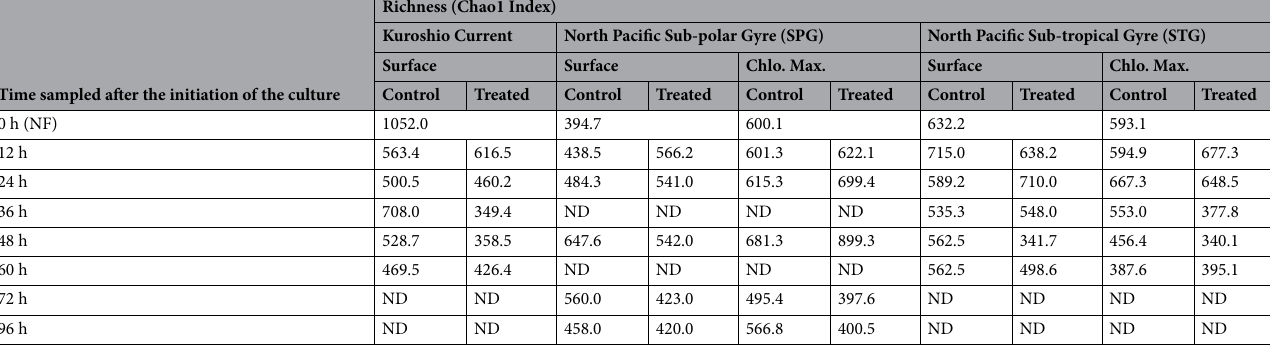
Table 4. Changes of species richness (Chao1 index) during the shipboard microcosm experiments with the water collected from the Kuroshio Current, North Pacific Sub-polar Gyre (SPG), and North Pacific Sub-